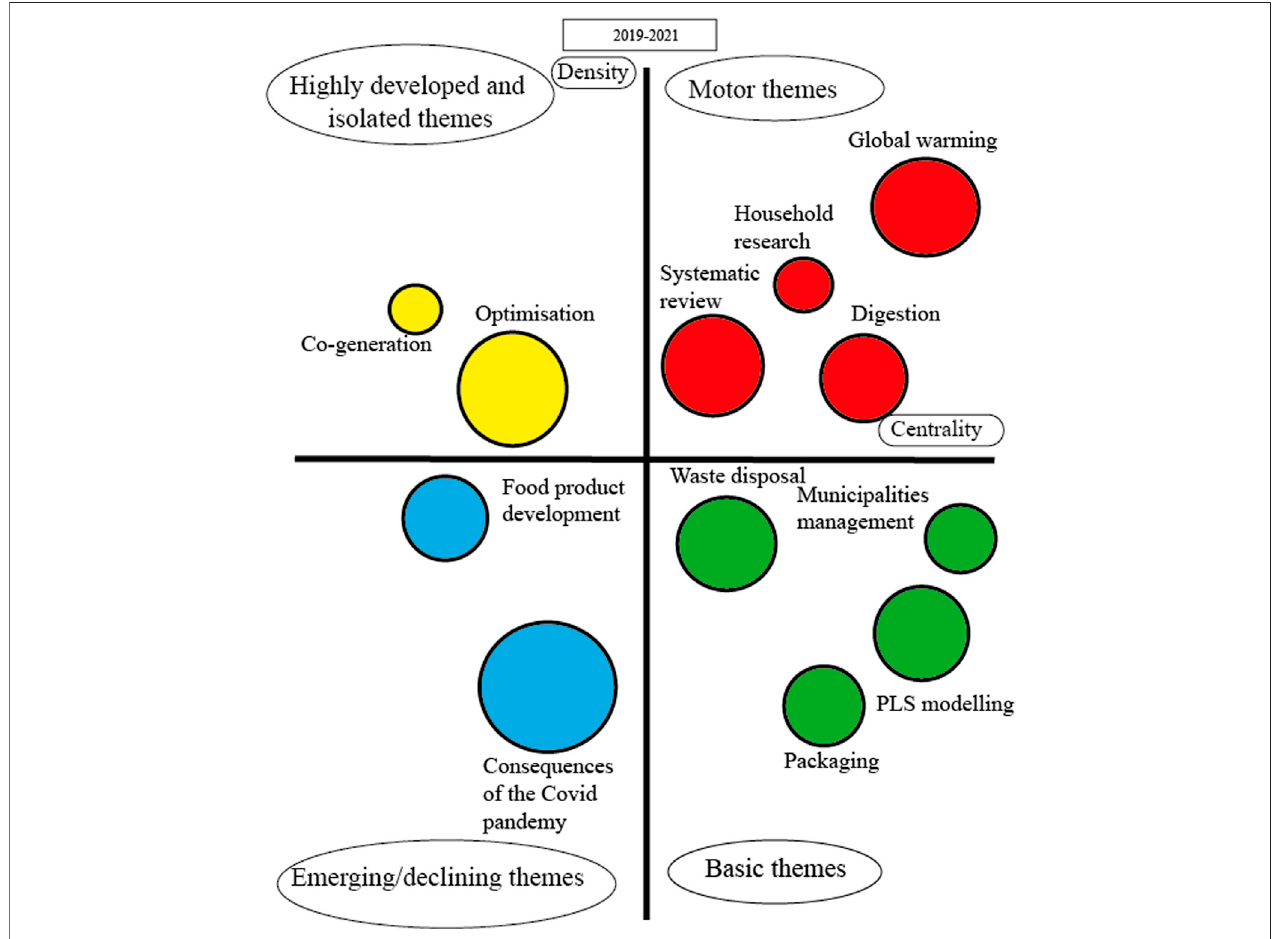
FIGURE 8 | Relative position of different themes on household food waste problem between 2019 –